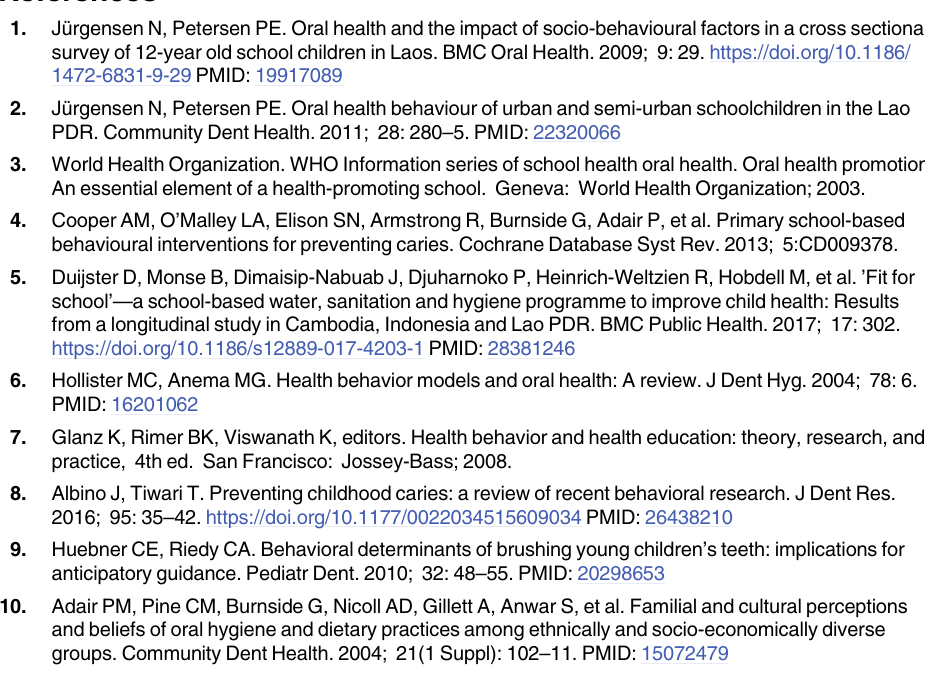
S2 File. Table: Characteristics and oral health behavior of the